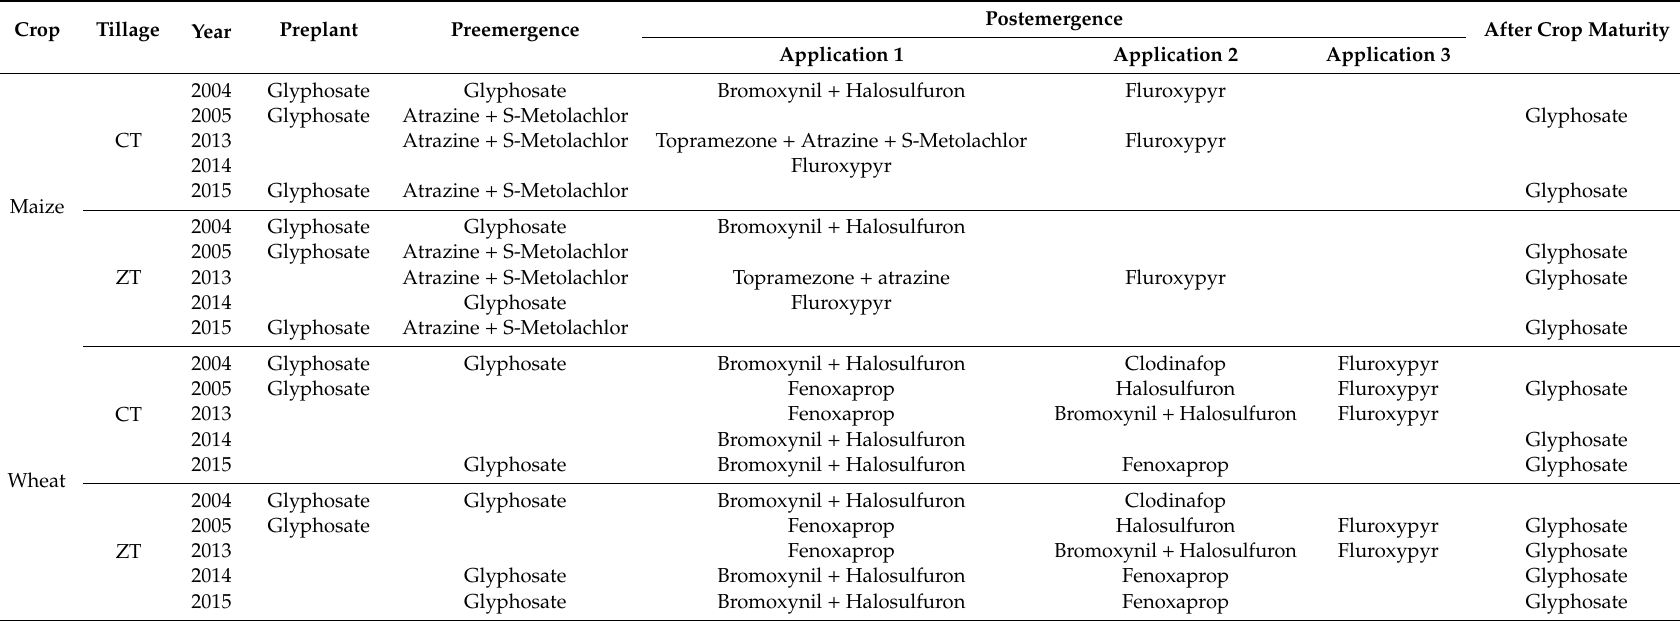
Table 2. Applications per crop, management and year during the years when weeds where studied in the